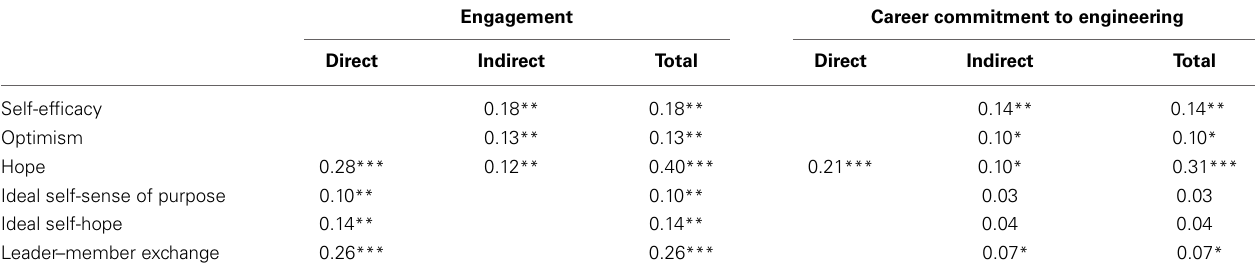
Table 5 | Direct, indirect and total effects of variables on work engagement and career commitment to engineering.